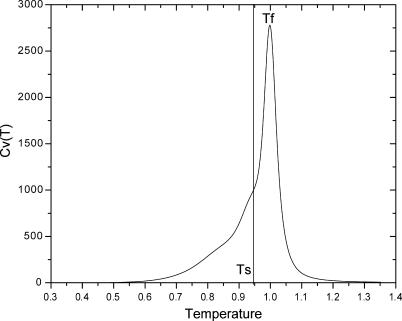
Heat Capacity Cv(T)The simulation temperature Ts = 0.944, and melting temperature Tf = 1.0. The Tf is defined from the peak of Cv, and Ts is determined from two-dimensional free-energy profile F(Qf
2,Qb). The simulation temperature was chosen so that the free-energy values at the loosely bound and bound states are equal.